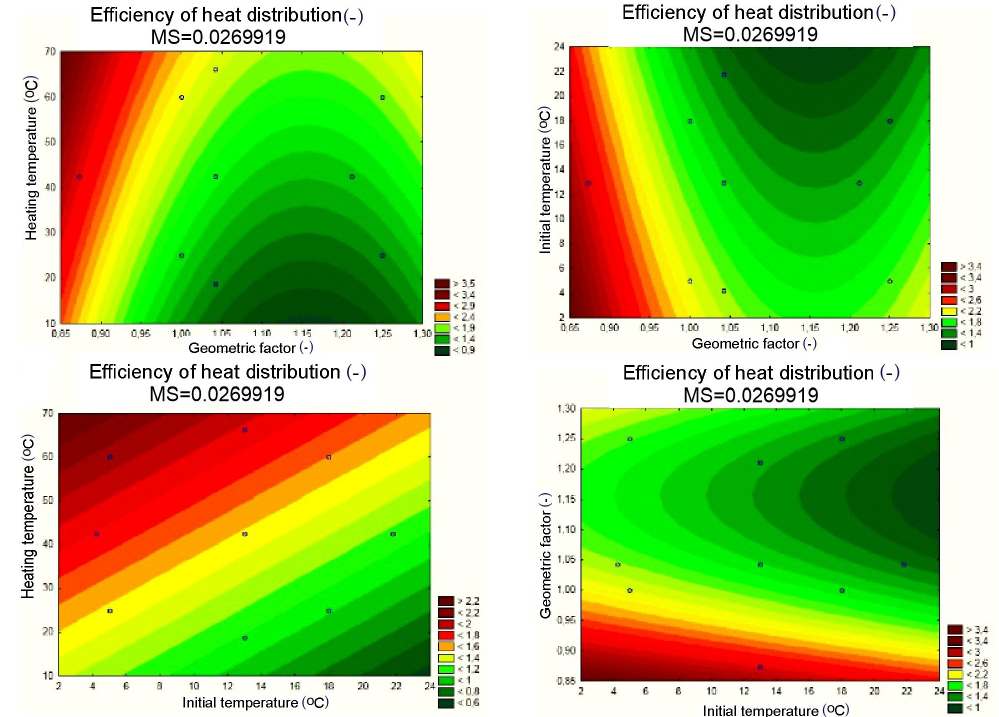
Figure 15. Response planes of the assumed polynomial approximation, presenting the impact of input quantities on the output quantity, applicable to the PCM/coke recyclate heat accumulator.